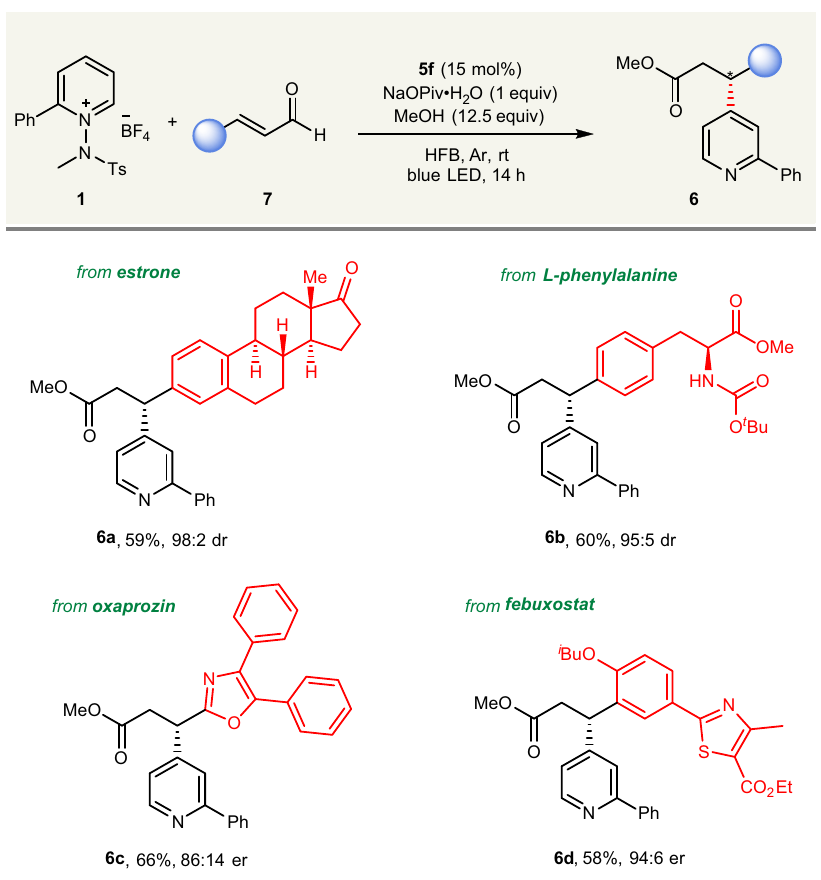
Fig. 3 Late-stage modi fi cation. Standard reaction